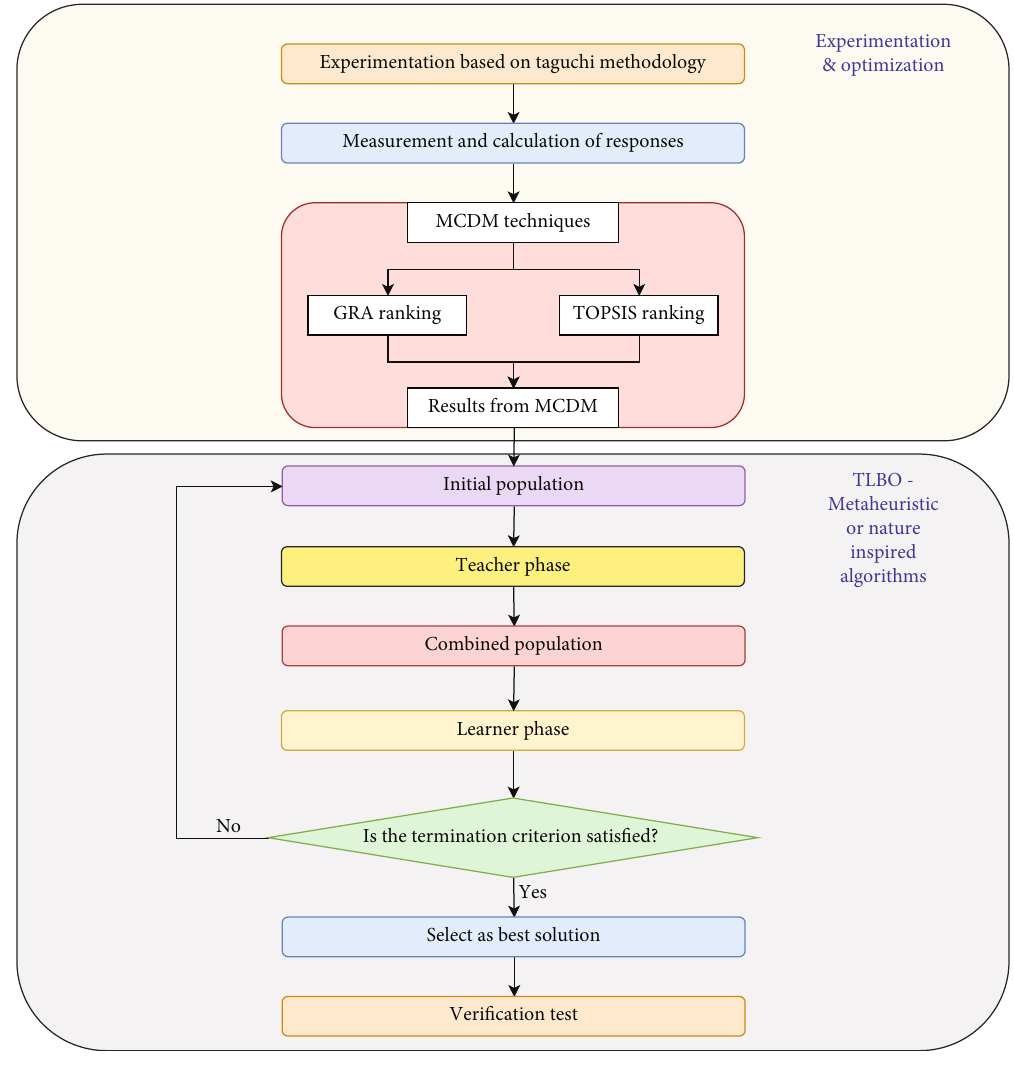
Figure 1: Proposed research plan (Srinivasan et al.